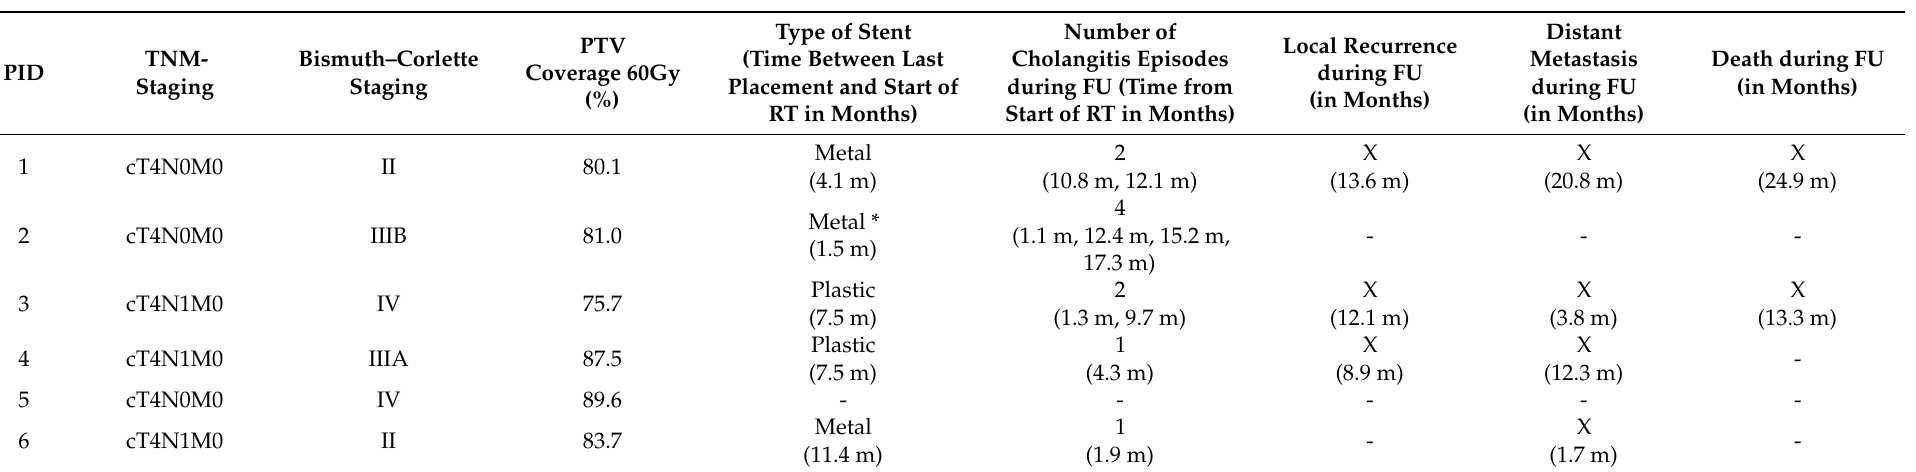
Table 7. Patient